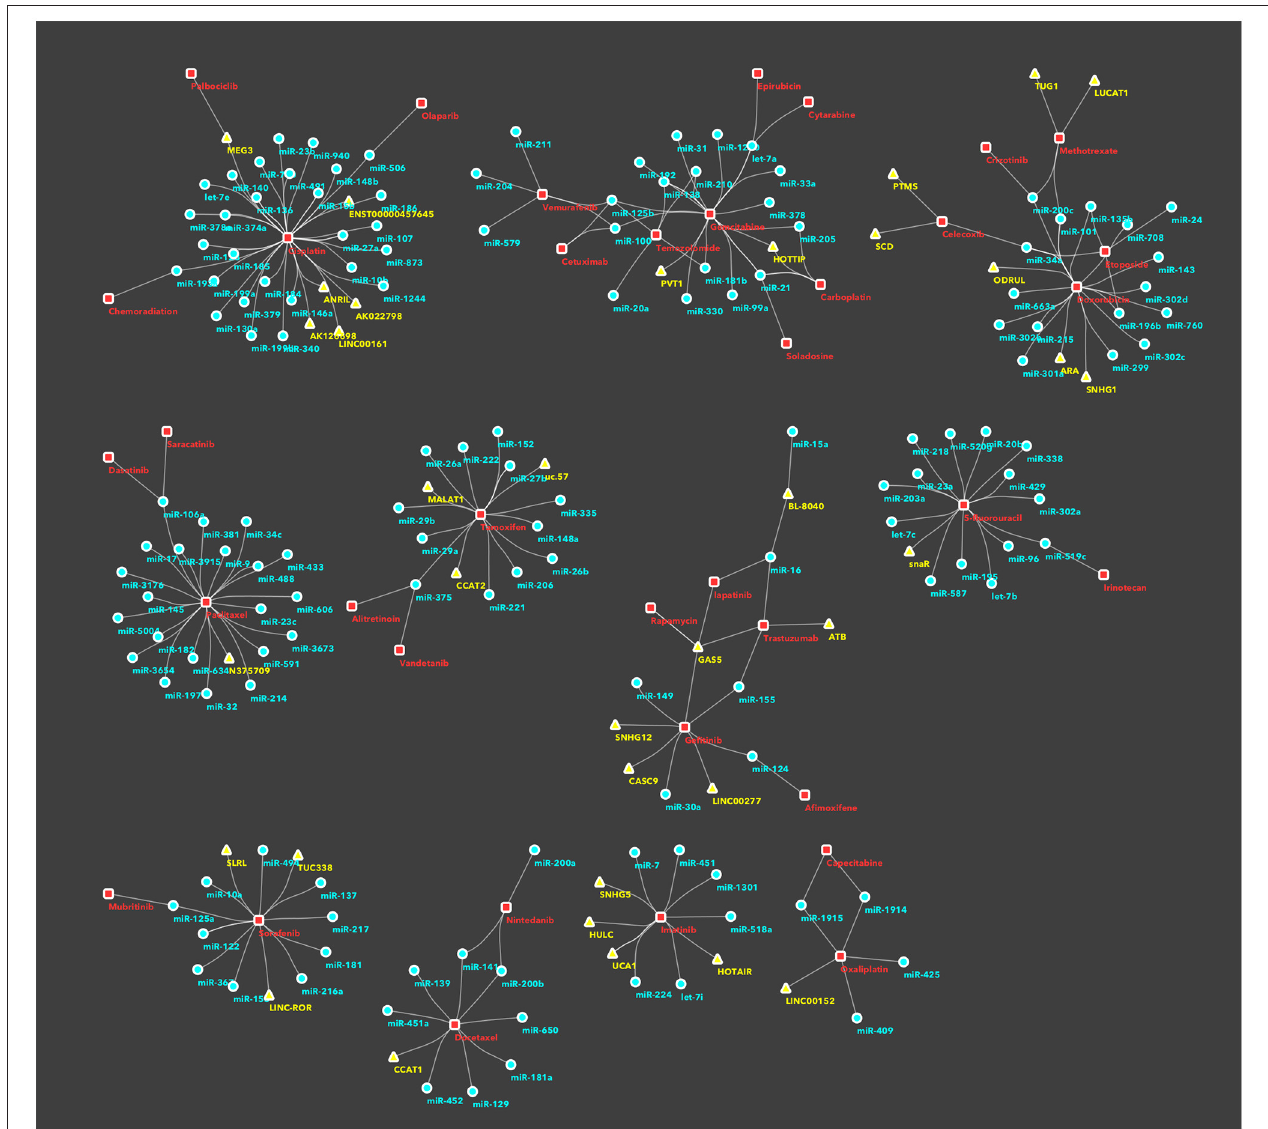
FIGURE 2 | Subnetworks/clusters of non-coding RNAs/drugs associations, according to community analysis. This figure depicts disjoint subnetworks corresponding to the different clusters in the whole network ( Supplementary Image 1 ) and identified using the community analysis tool in Cytoscape. This is a simplification of the involvement of ncRNAs in drug resistance, as an ncRNA, or a drug, is represented only in a single cluster/subnetwork. For sake of completeness, all interactions are described in the main text and presented in the Supplementary Table 1 .